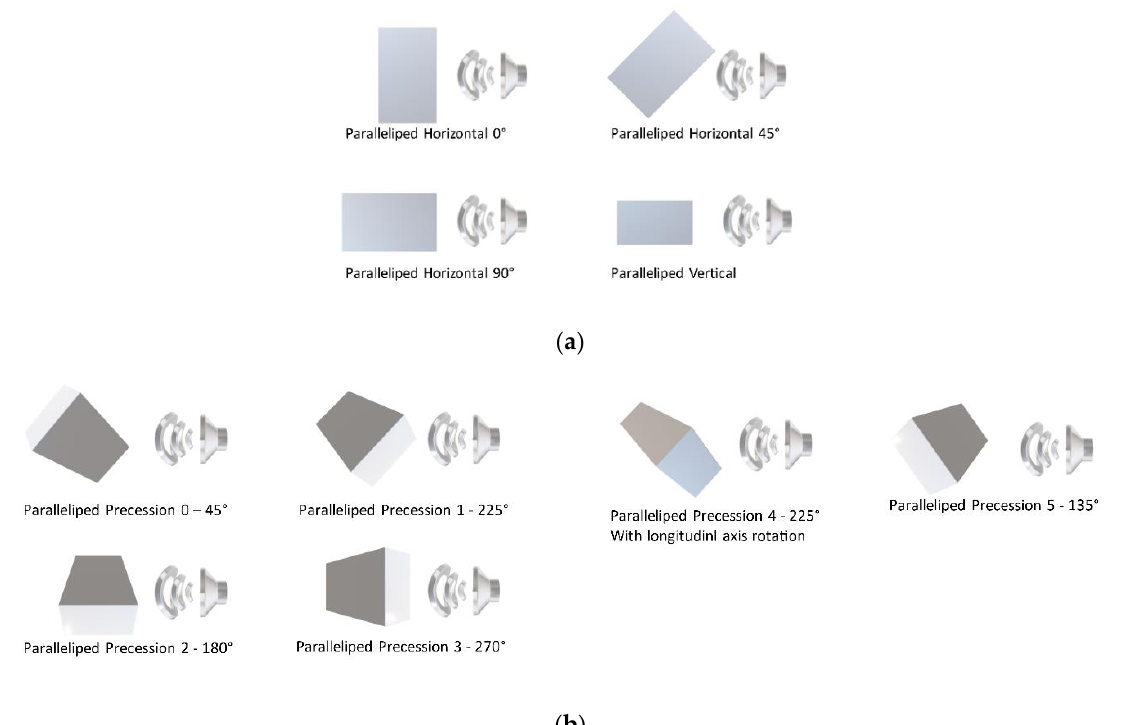
Figure 6. Parallelepiped positioning in respect to wave incidence direction. ( a ) Horizontal and vertical positions; ( b ) preces- sion